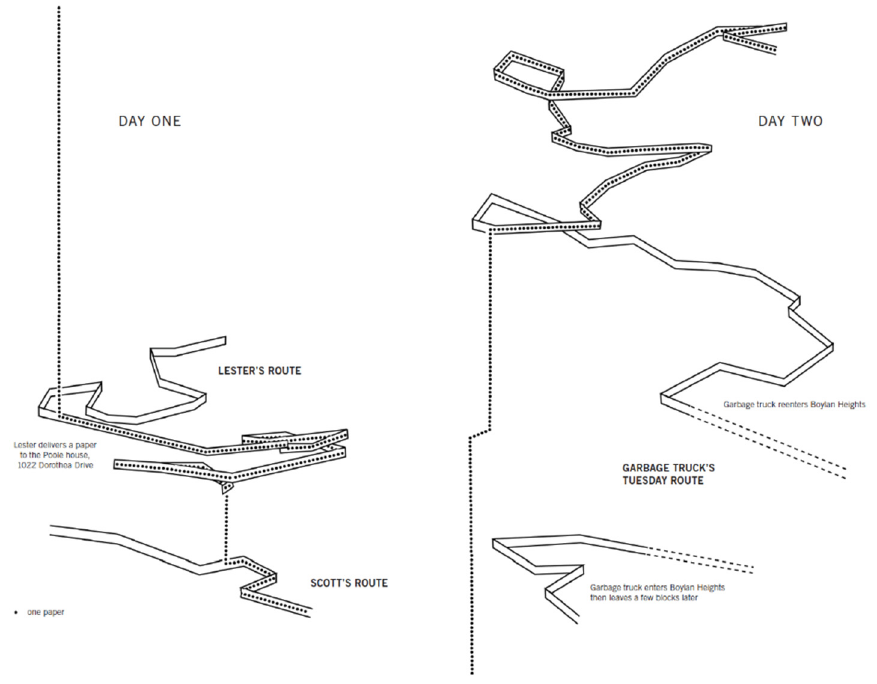
Figure 8. The Paper Route, data collected by Diane Pacella, Tim Hess, and Aurora Dee, map by Denis Wood ([5], p. 71, used with